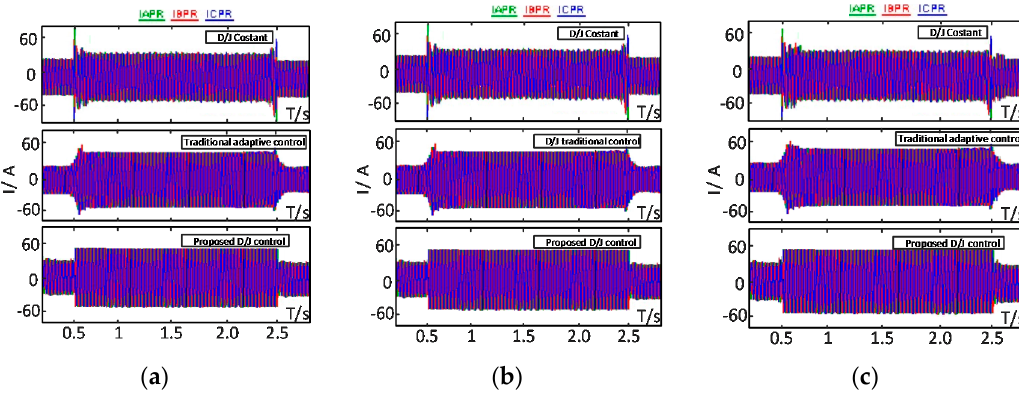
Figure 11. Current responses among different controllers: ( a ) VSG1; ( b ) VSG2; ( c ) VSG3.